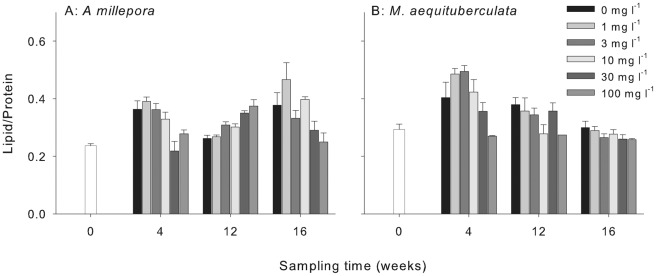
The effect of sediment treatment on lipid normalized to biomass (mg lipid/mg protein) at each of the sampling periods for (A) A. millepora and (B) M. aequituberculata (bars + SE, n = 9 corals per treatment per sampling period).Nine corals were collected at t = 0 days to represent all of the initial treatments.